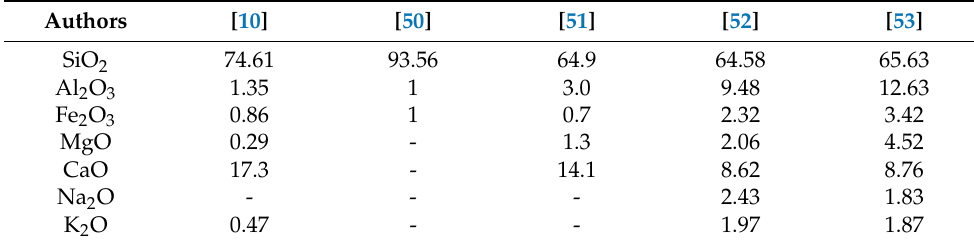
Table 2. Chemical Composition of Dune